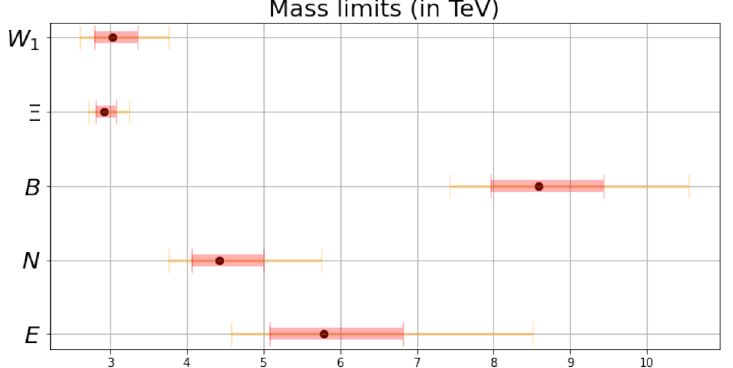
Figure 6 . The horizontal bars show the mass limits (in TeV) at the 68 and 95% CL for the models described in table 2, setting the corresponding couplings to unity. A larger (smaller) coupling would increase (decrease) the mass ranges proportionally. The coupling limits obtained when setting the mass to 1 TeV are listed in table